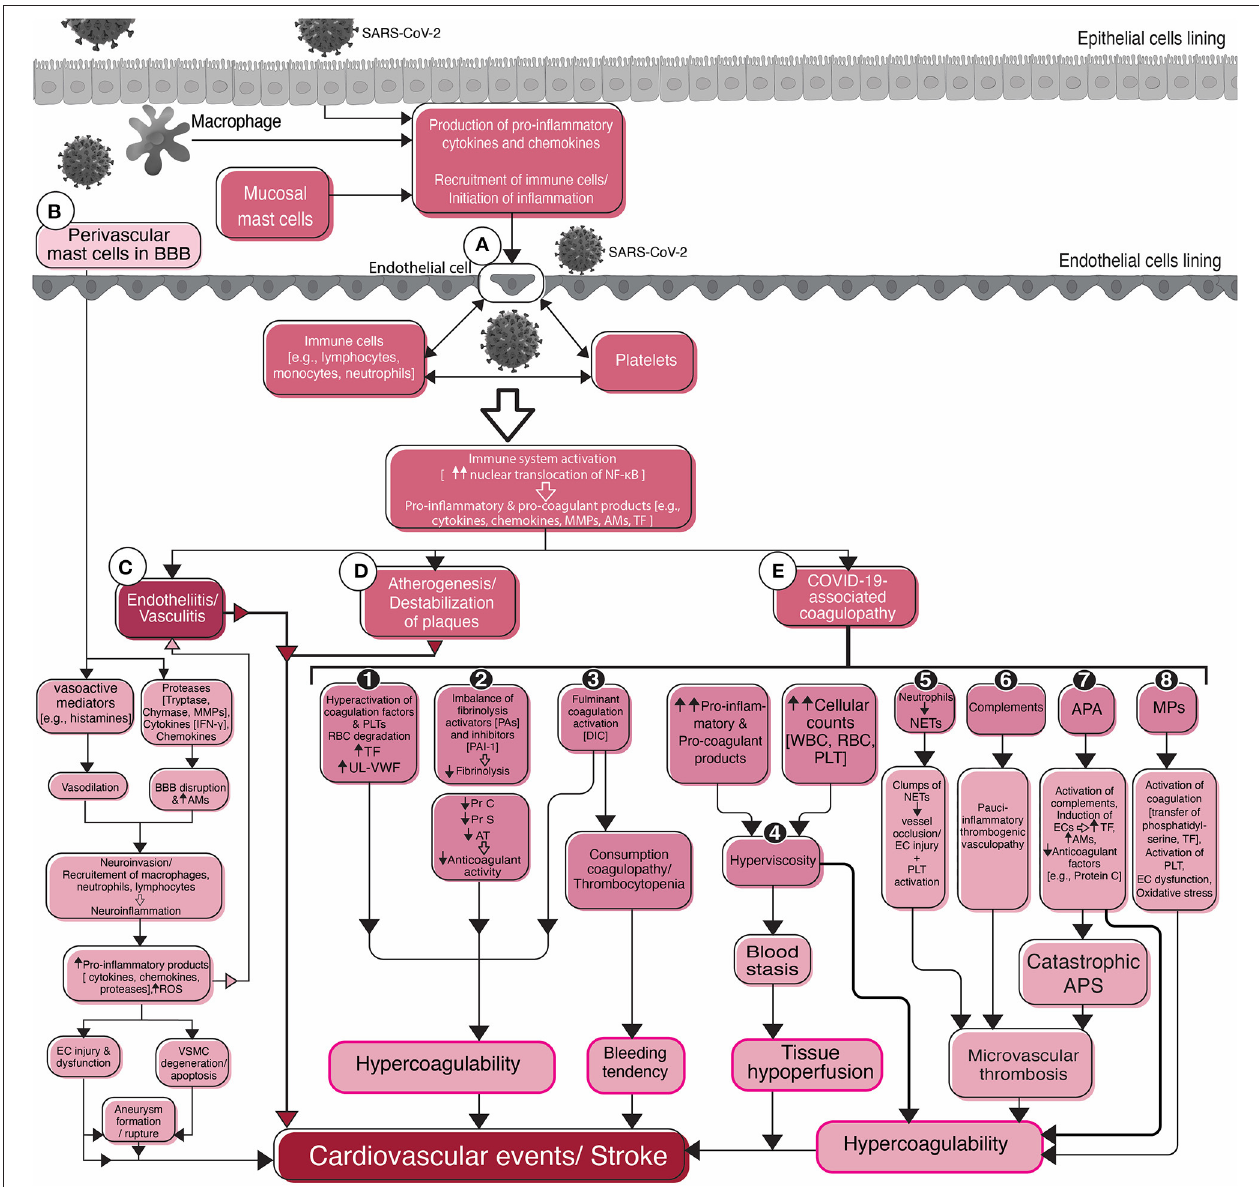
FIGURE 2 | Flowchart diagram shows the roles of endothelial cells, platelets, the inflammatory system, and the coagulation system in SARS-CoV-2-associated stroke and cardiovascular events. Viral infection of epithelial cells of the mucosal linings stimulates them for the production of pro-inflammatory cytokines and activation of the immune system. Macrophages and mast cells residing in the mucosal tissues also participate in the activation of the immune system in the early stages of infection. Activation of and interaction between the immune system, endothelial cells, and platelets (A) in circulation result in stroke complications. Common sequelae include endotheliitis, or vasculitis (C) , atherogenesis, or destabilization of pre-existing atherosclerotic plaques (D) , and COVID-19-associated coagulopathy (E) . Different mechanisms that are attributable to COVID-19-associated coagulopathy are depicted in detail (1–8) . The possible role of mast cells in the blood-brain barrier (BBB) disruption, initiation and/or aggravation of inflammation, neuroinvasion, and stroke are summarized in the left side of the figure (B) . Mast cells, one of the two resident immune cells (microglia is the second one), cause BBB damage leading to the recruitment of peripheral immune cells and the virus into the brain and inflammation in the cerebral vasculature and subsequent stroke. SARS-CoV-2, Severe acute respiratory syndrome coronavirus 2; BBB, Blood-brain barrier; NF- κ B, Nuclear factor-kappa B; MMPs, Matrix metallopeptidases; AMs, Adhesion molecules; TF, Tissue factor; IFN- γ , Interferon-gamma; ROS, Reactive oxygen species; EC, endothelial cell; VSMC, Vascular smooth muscle cell; PLT, Platelet; RBC, Red blood cell; UL-VWF, Ultra large-von Willebrand factor; PA, Plasminogen activator; PAI-1, Plasminogen activator inhibitor-1; Pr, Protein; AT, Antithrombin; DIC, Disseminated intravascular coagulation; WBC, White blood cell; NETs, Neutrophil extracellular traps; APA, Antiphospholipid antibodies; APS, Antiphospholipid syndrome; MPs, Microparticles.